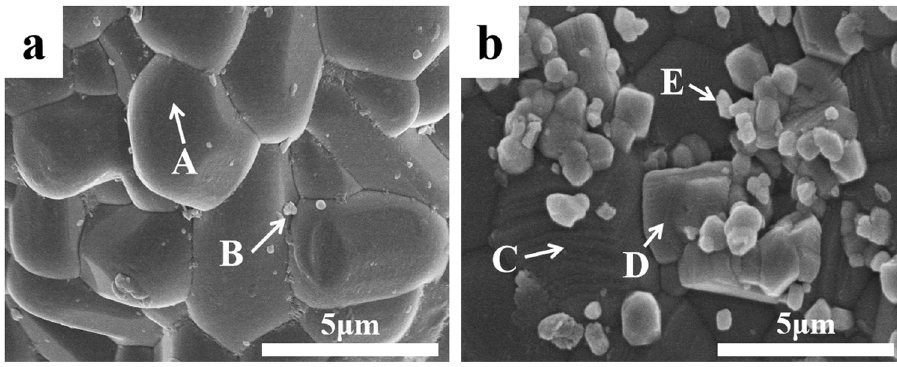
Figure 2: SEM images of Cr 3 C 2 – NiCr powders: ( a ) CP and ( b )